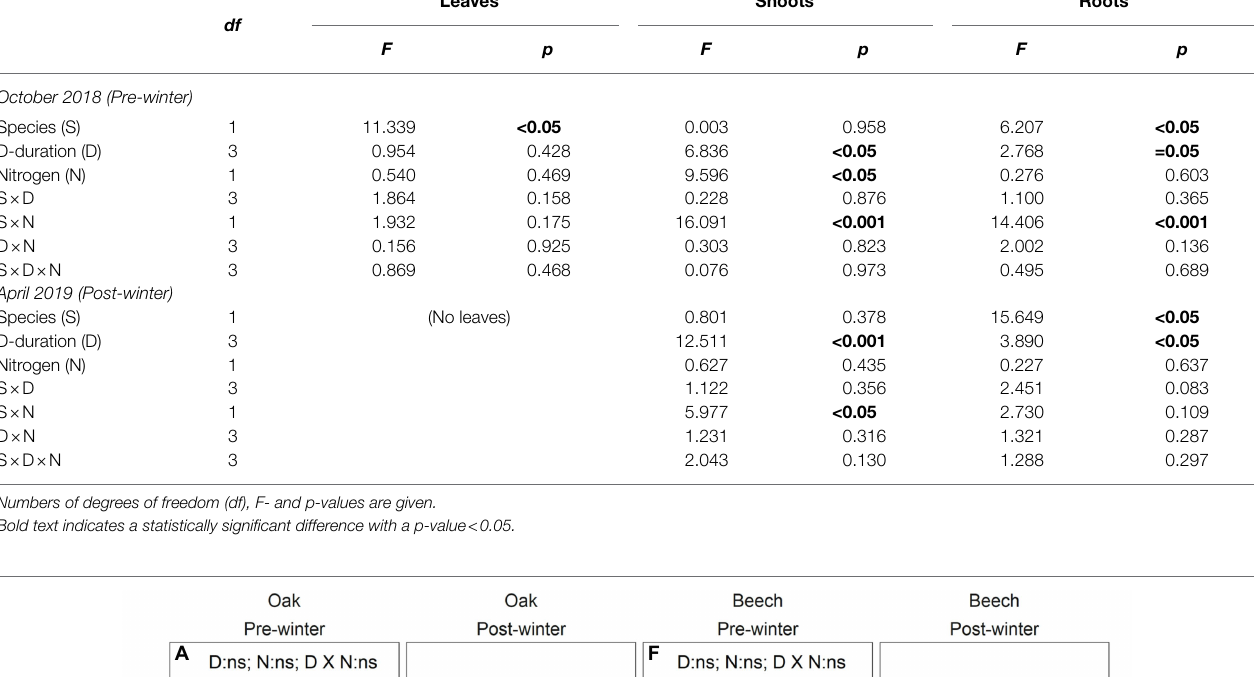
TABLE 2 | Results of linear mixed models with species (S), drought duration (D), nitrogen fertilization (N) as factors, for tissue NSC concentrations after the drought duration treatment in the growing season 2018 (pre-winter) and before the growing season 2019 (post-winter). Leaves Shoots Roots df